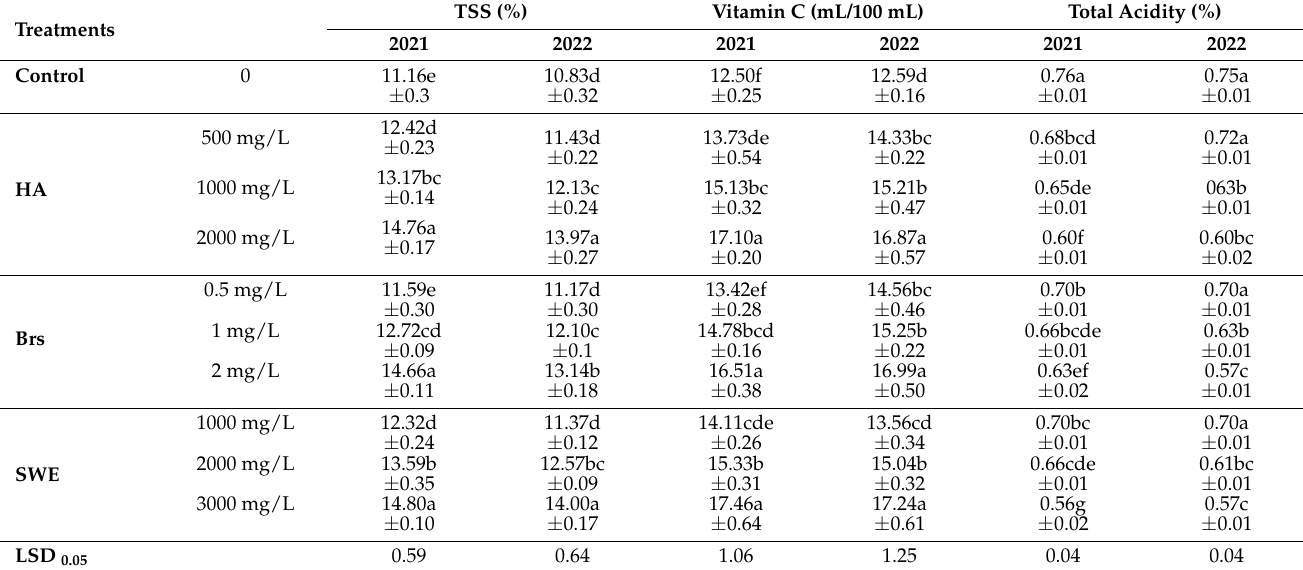
Table 7. Effect of foliar spraying of HA, Brs, and SWE on the fruit content from the total soluble solids, vitamin C, and total acidity of apricot cv. Canino during